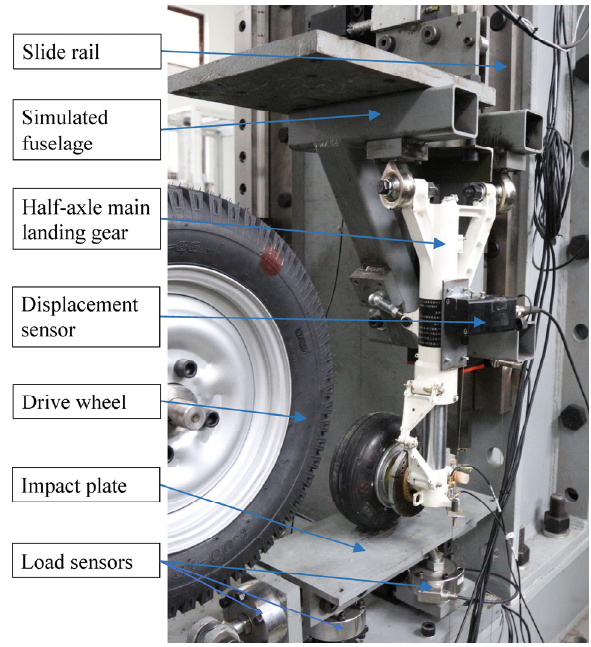
Figure 6. Drop test system of the single landing gear.